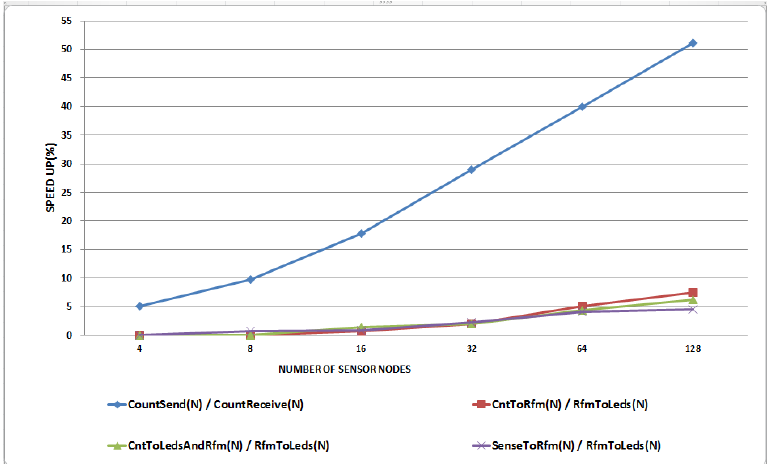
Figure 8. Simulation speedup with various numbers of nodes (N senders, N